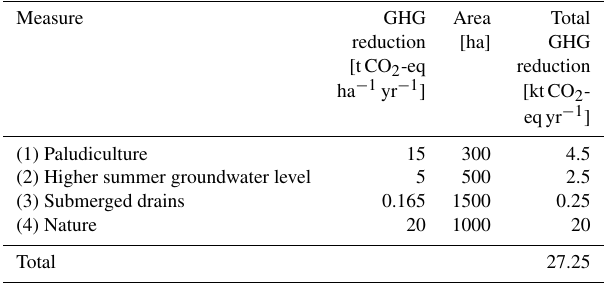
Table 2. Calculation of total possible GHG reduction until 2030 for the agricultural peat meadow in the water management area of